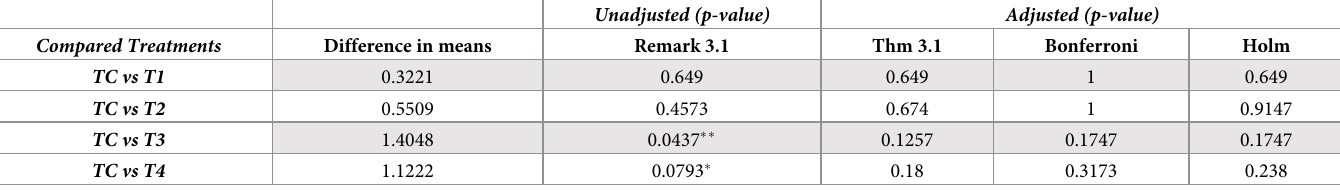
Unadjusted (p-value)